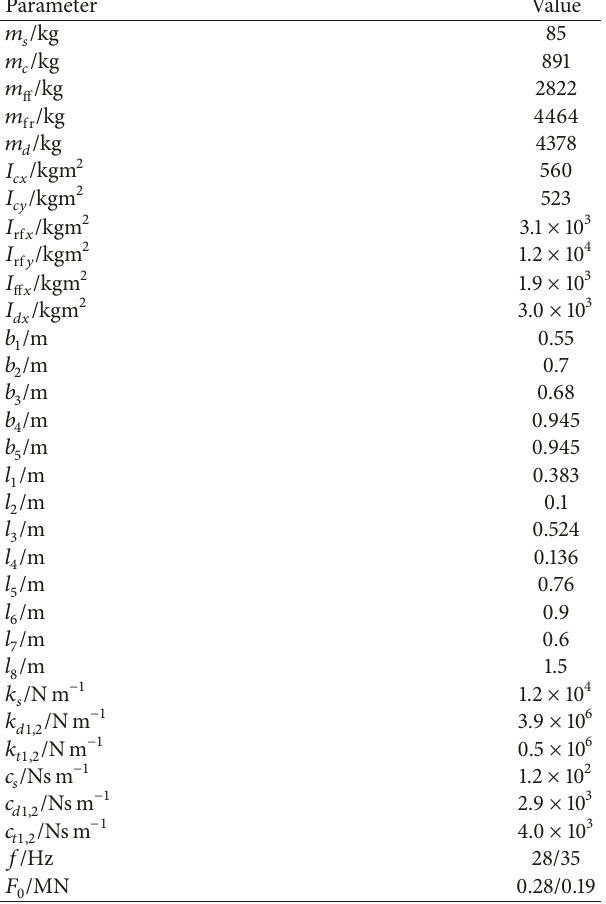
Table 2: The reference parameters of a single drum vibratory roller.